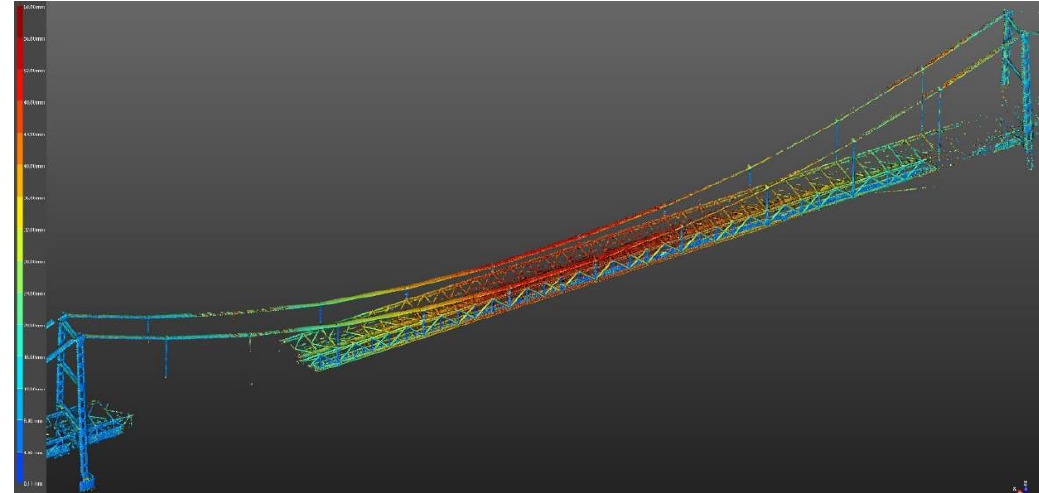
Figure 10. Bridge displacements under load scenario A shown by means of color deviation maps (Trimble TX8 scanner).